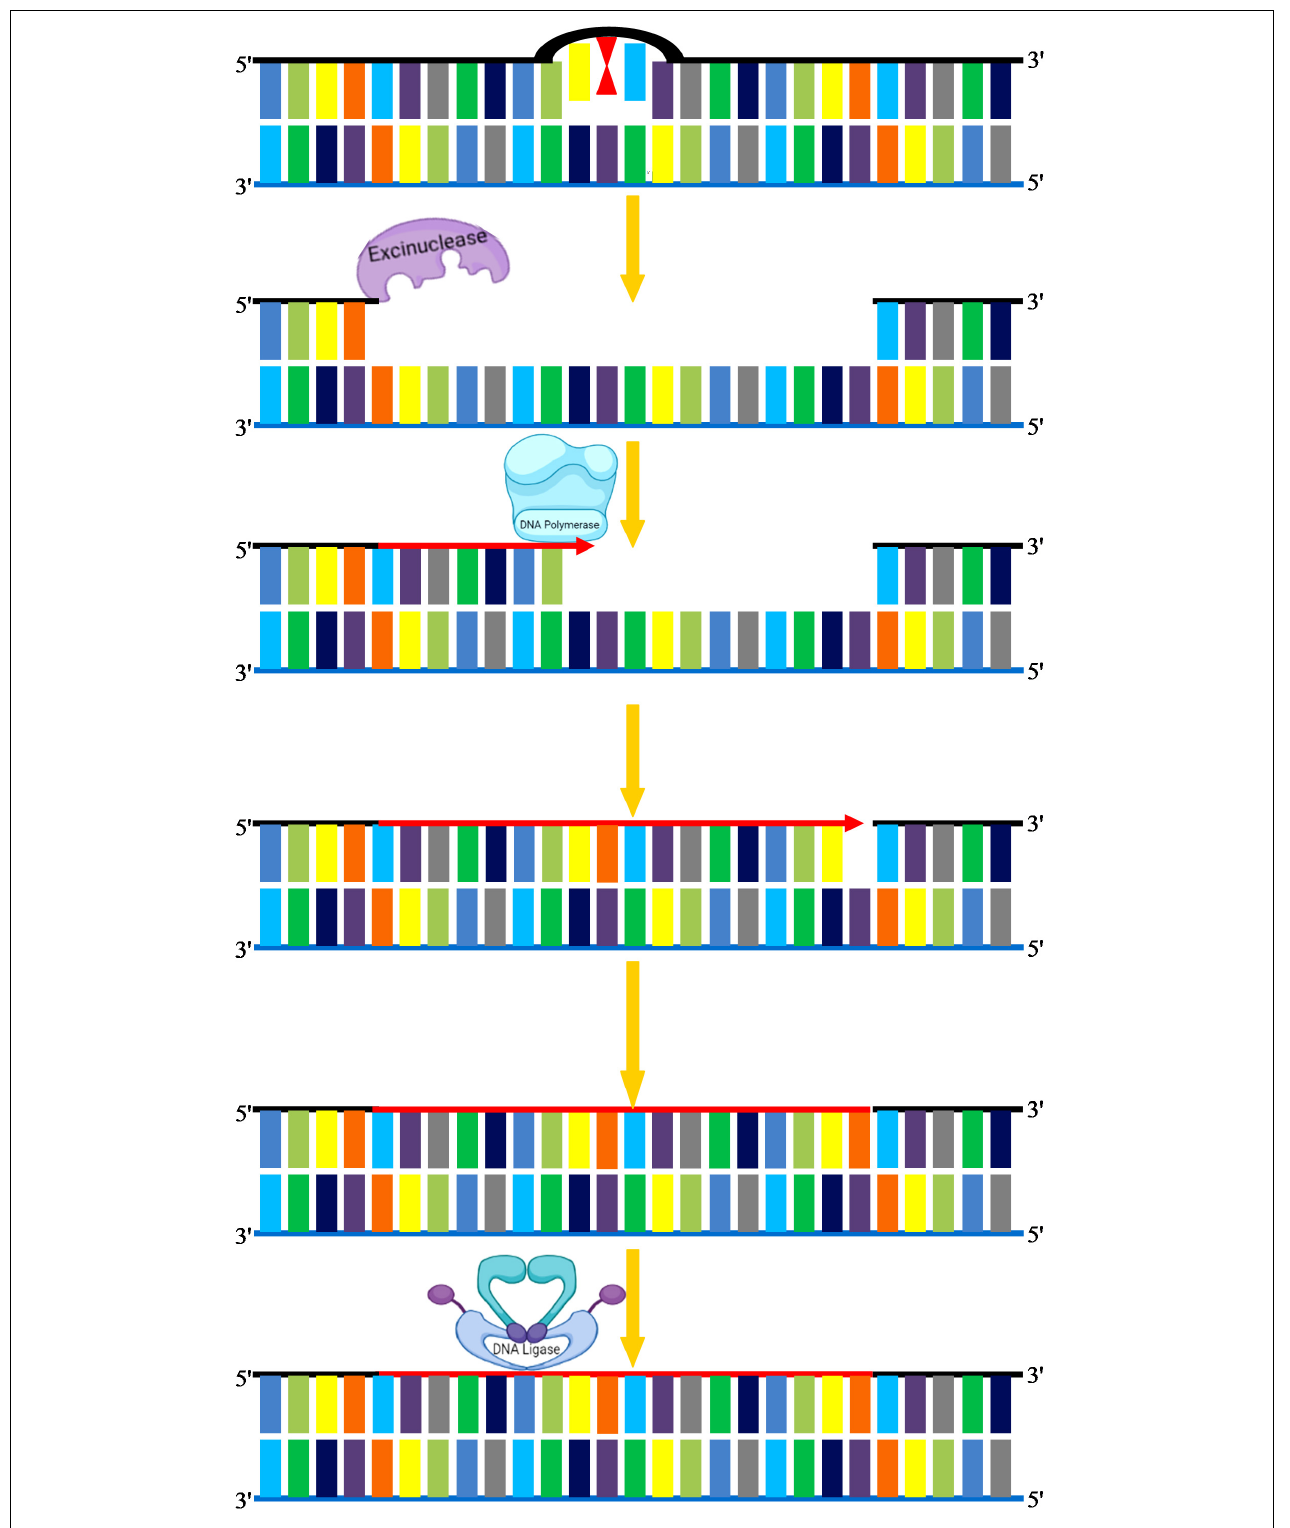
FIGURE 7 | Nucleotide excision repair. NER eliminates these adducts by making an incision on both sides of adduct by excinucleases followed by the removal of this incised stretch of DNA. DNA polymerase I replaces the damaged portion with a new DNA. The gap is eventually filled by DNA ligase.